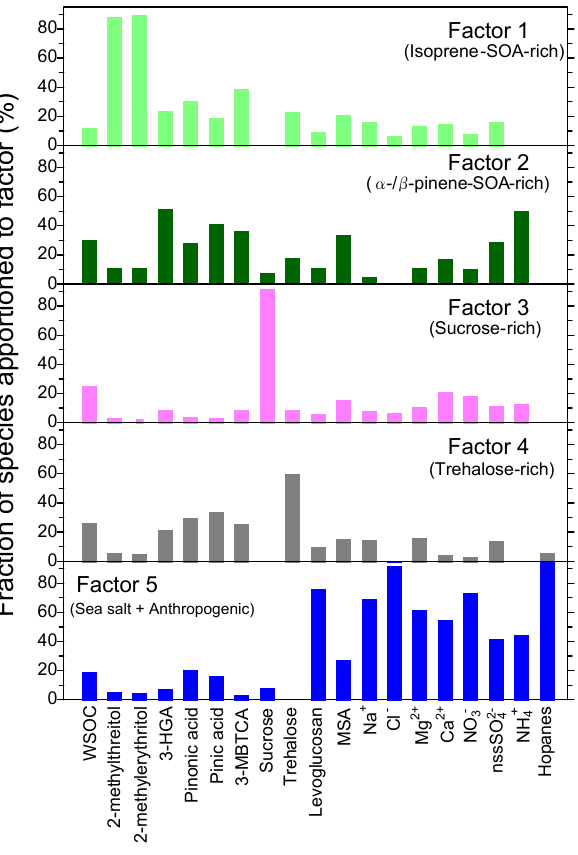
Fig. 3. Five compositional WSOC source factors isolated by PMF.